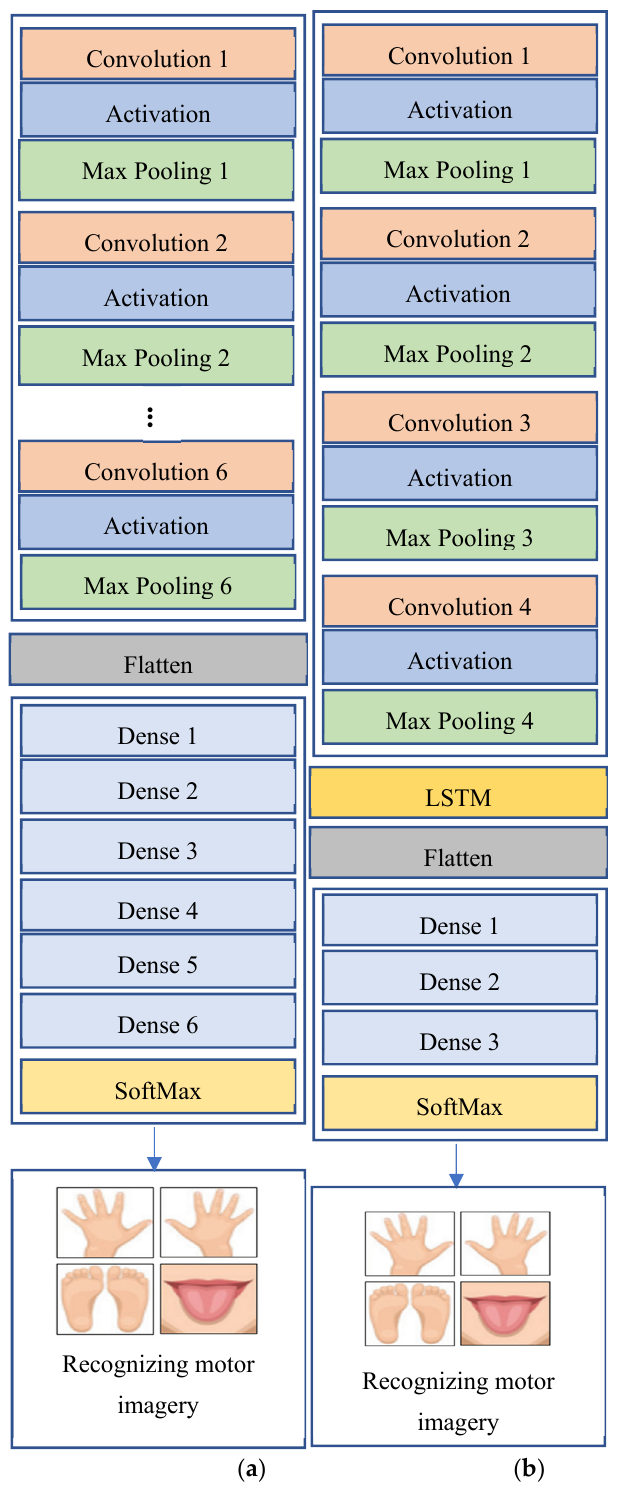
Figure 7. The proposed ( a ) CNN1 and ( b ) CNN2 model.